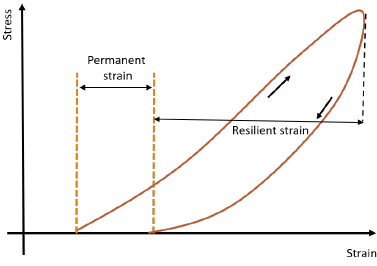
Figure 5. Stress regime in a soil element due to a single moving wheel load. Adapted with permission from [25]. 2021 Fredrick